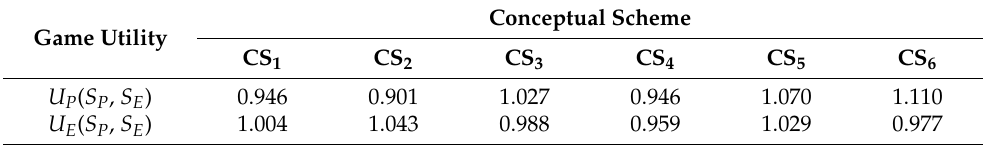
Table 10. Game utility matrix of warehouse logistics system under each strategy combination.